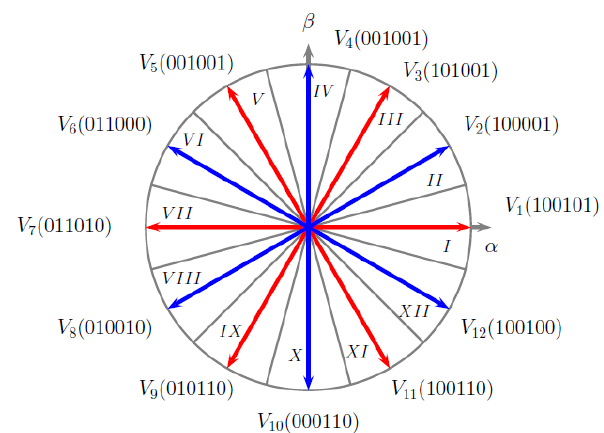
Figure 5. Voltage vectors and sectors for a Direct Torque Control of 2 and 3 phases